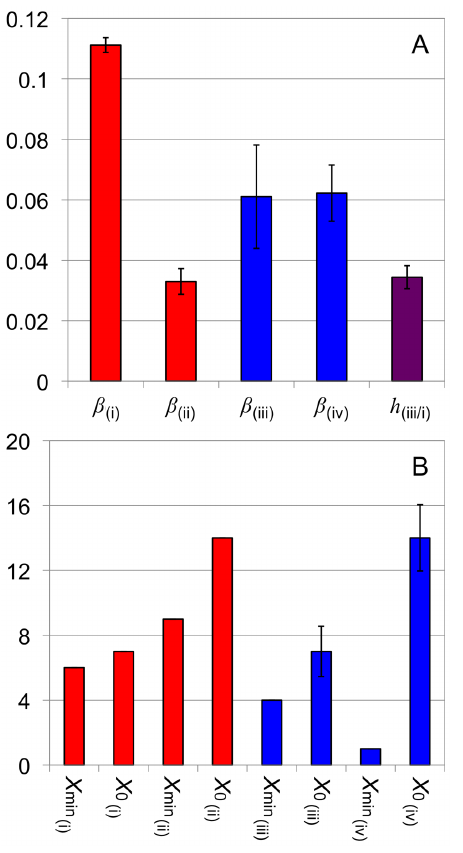
Figure 4. Fitted parameters for six replicates of the CLD described in Figure 2. (A) Averages and 6 standard deviations (thin bars) of b (the relative branching activity from an enzyme set to that of the total propagation from set (i) and (ii) in the SL range, or (iii) and (iv) in the TL range) from different enzyme sets; h (iii/i) is the ratio of the maximum of type-2 TL CLD to that of the SL CLD. (B) The modes (highest repeating values) of X 0 and X min (which are discrete variables) from different enzyme sets. Where the thin bars are not seen means the standard deviation is small. The red and blue colors correspond to the calculated SL and type-2 TL CLD in Figure